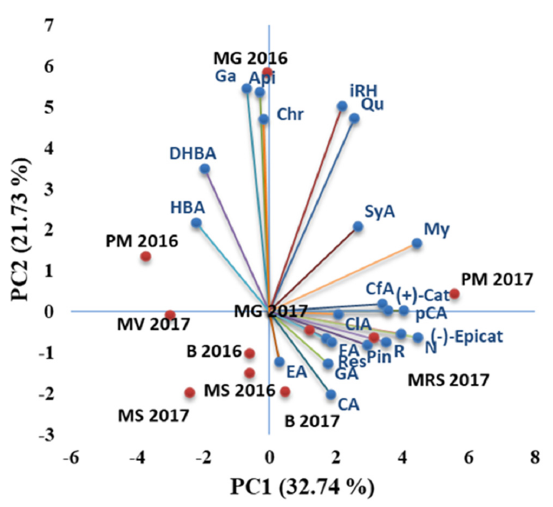
Figure 3. Principal Component Analysis (PCA) of the fruits of different chestnut cultivars based on individual phenolic compounds (‘Pr é coce Migoule’—PM, ‘Bournette’—B, ‘Marsol’—MS, ‘Marissard’—MRS, ‘Marigoule’—MG and ‘Maraval’—MV).